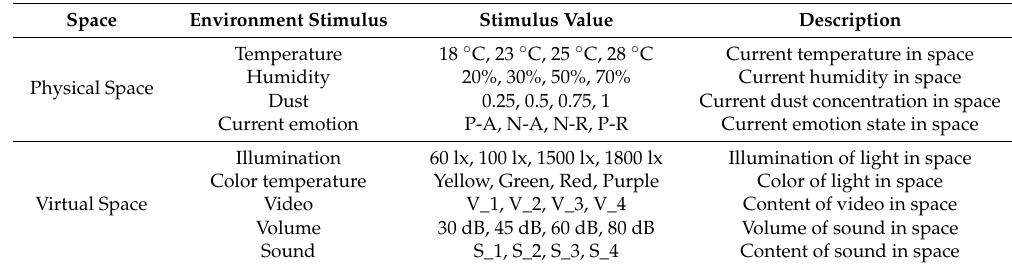
Table 5. System configuration (for video and sound, stimuli 1, 2, 3, and 4 induce P-A, N-A, N-R, and P-R respectively).